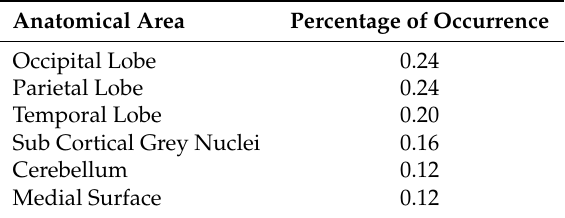
Table 3. Most occurring anatomical